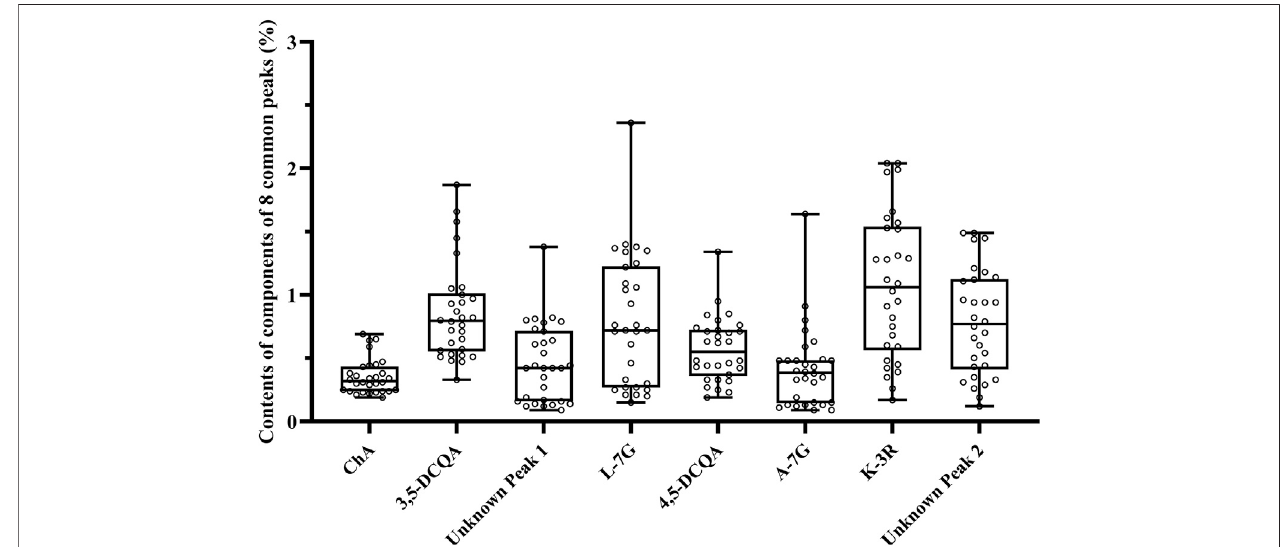
FIGURE 5 | The box diagram of the contents of eight common peaks in 30 fl ower head samples of CMs.